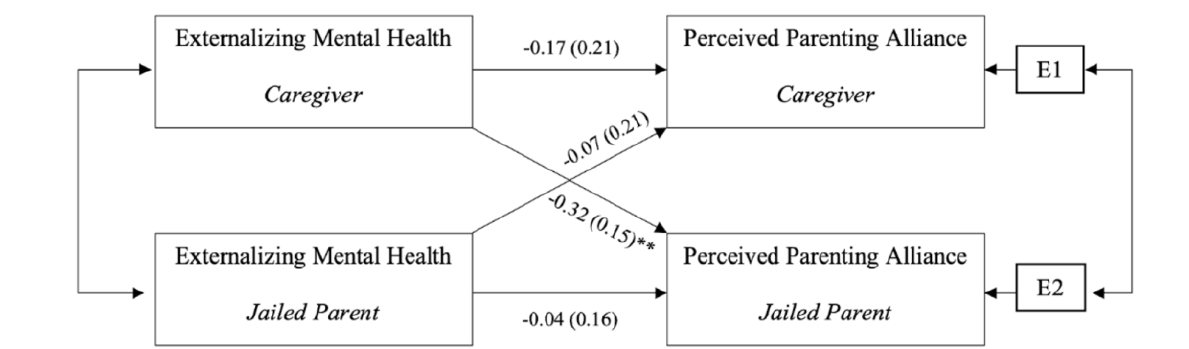
Figure 2. APIM results between externalizing symptoms and perceived coparenting alliance. ** p < 0.01.